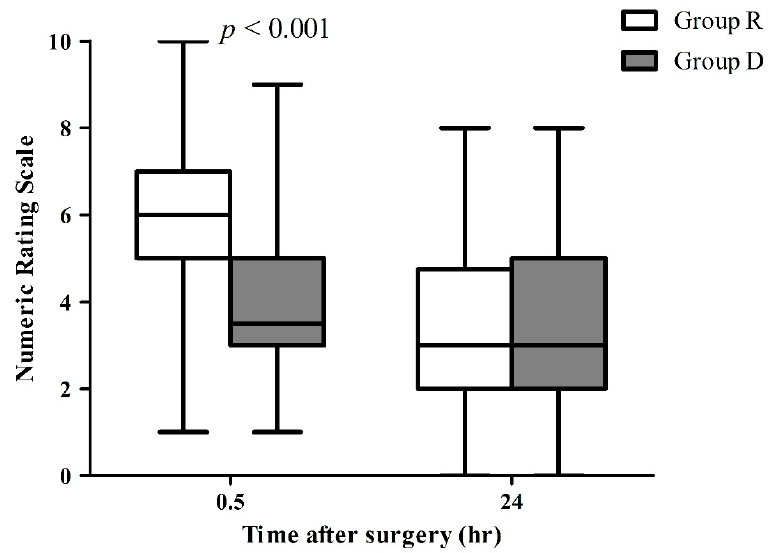
Figure 2. Postoperative pain difference between the two groups. Box plot with median (solid line), 25–75th percentiles (box), and min-max (whiskers). Mann–Whitney’s U test was used.